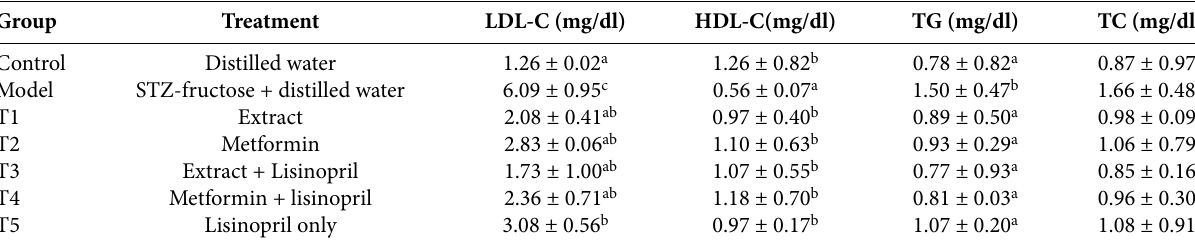
Table 6. Effect of treatments on serum lipid profiles